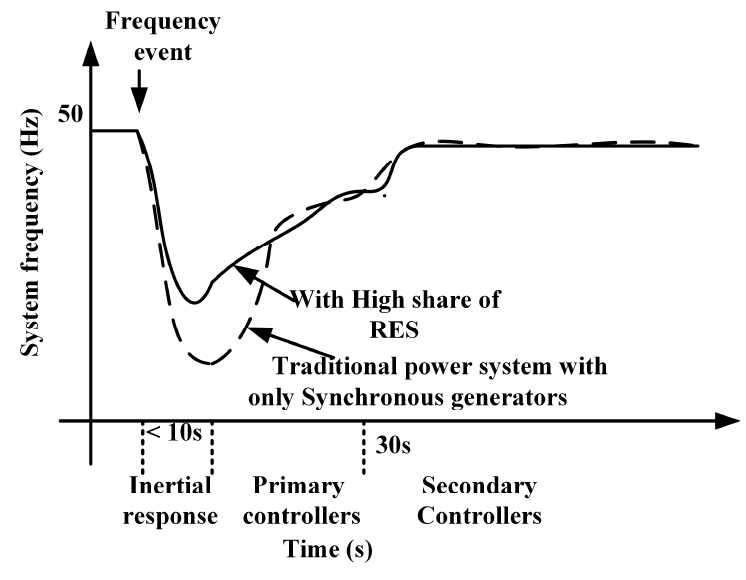
Figure 4. Frequency response in a power system network.